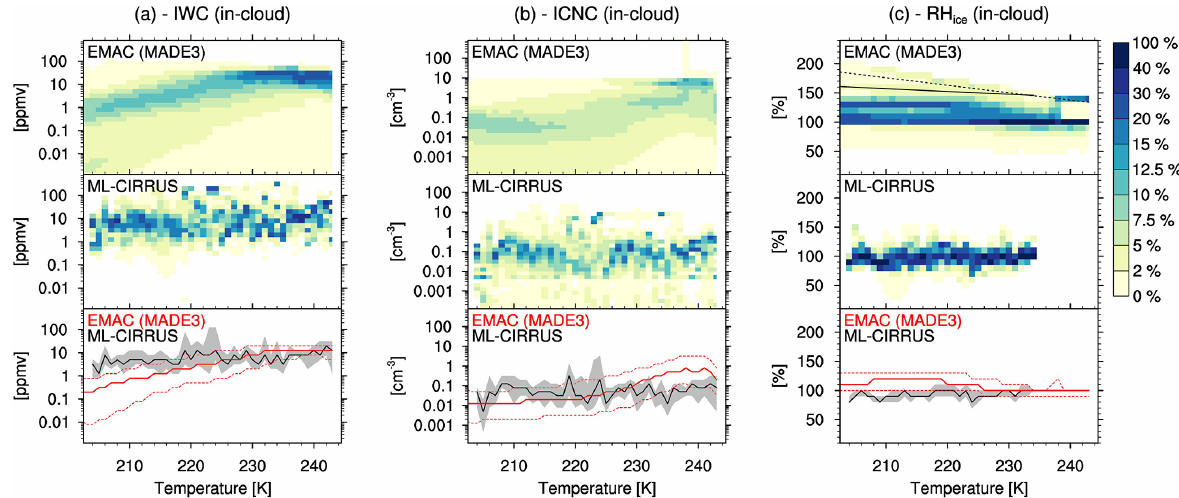
Figure 6. As in Fig. 5 but comparing to observational data from the ML-CIRRUS campaign. Shown are in-cloud ice water content (a) , in-cloud ice crystal number concentration (b) , and in-cloud relative humidity with respect to ice (c) .